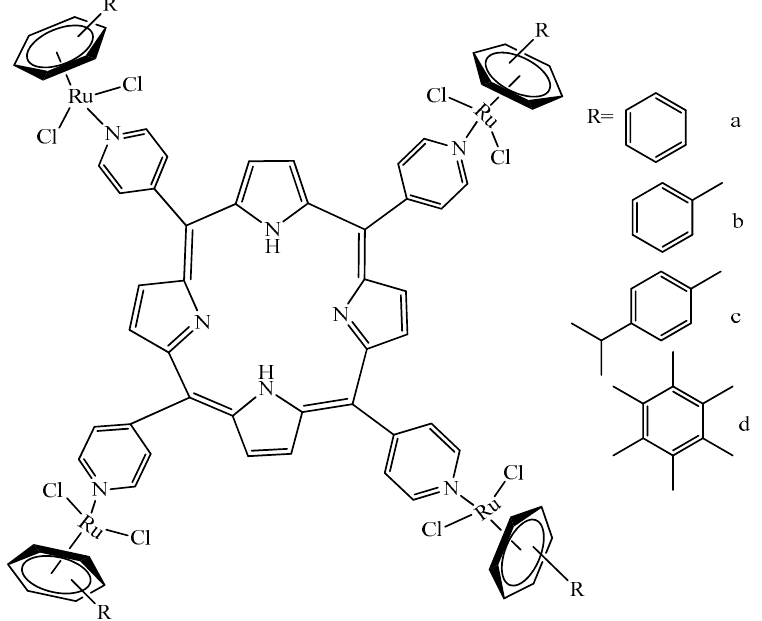
Figure 3. Chemical structure of Ru(II) based on meso-4 ′ -tetrapyridylpyrin. Adapted from Ref. [48] with permission from the Chem. Sci. , Copyright 2015.